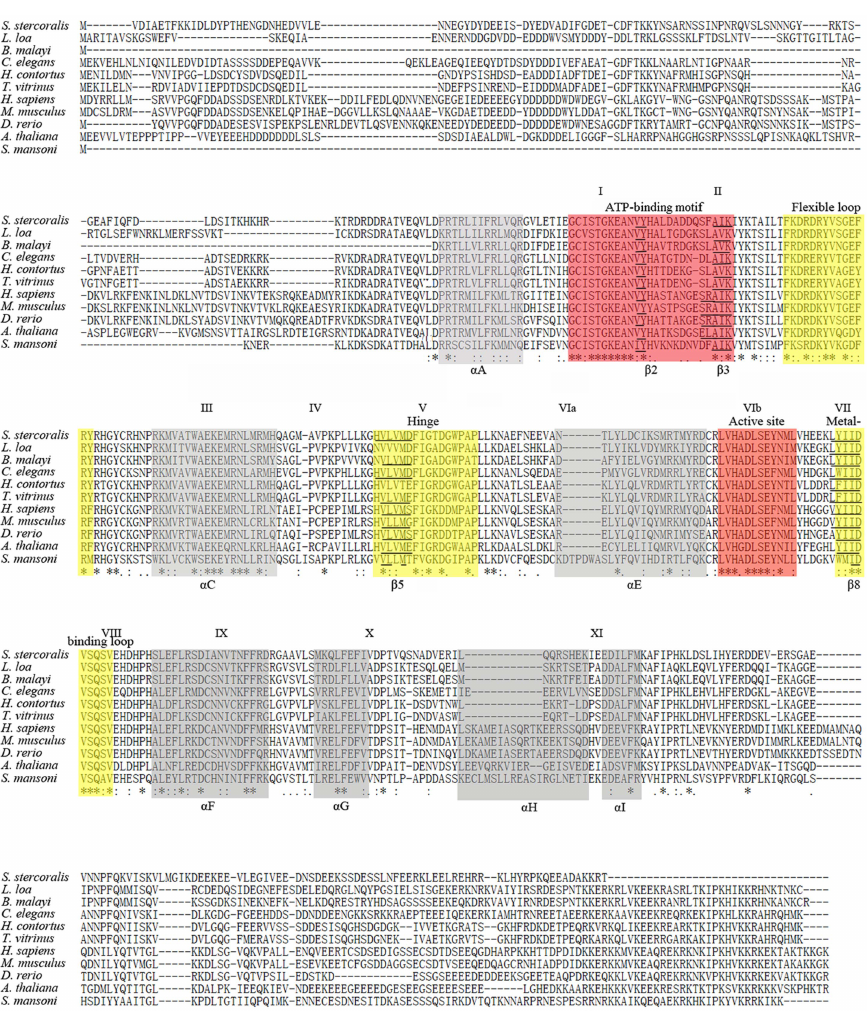
Figure 1. Alignment of the inferred amino acid sequences of StrongyloidesstercoralisSs -RIOK-1 with RIOK-1s from nine other species. The nine selected species are Loa loa (XP_003135673.1, Ll -RIOK-1), Brugia malayi (EDP30009.1, Bm -RIOK-1), Caenorhabditis elegans (CCD67367.1, Ce -RIOK-1), Haemonchus contortus (ADW23592.1, Hc -RIOK-1), Trichostrogylus vitrinus (CAR64255.1, Tv -RIOK-1), Homo sapiens (NP_113668.2, Hs -RIOK-1), Mus musculus (NP_077204.2, Mm -RIOK-1), Danio rerio (NP_998160.1, Dr -RIOK-1), Arabidopsis thaliana (NP_180071.1, At - RIOK-1), Schistosoma mansoni (XP_002573653.1, Sm -RIOK-1). Alpha-helices A-I or beta-sheet structures are highlighted with light grey and marked under the alignment. The subdomains I-XI are marked above the alignment. Functional domains including ATP-binding motif (red), flexible loop (yellow), hinge (yellow), active site (red) and metal binding loop (yellow) are highlighted and labeled above the alignment. Asterisks indicate identical residues.